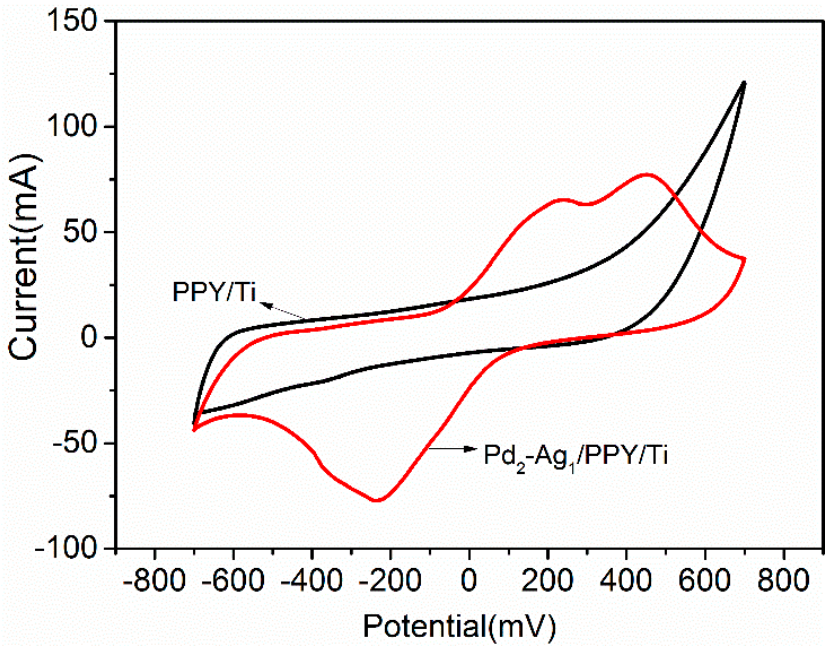
Figure 2. CV curves of the PPY/Ti and Pd-Ag/PPY/Ti electrodes.